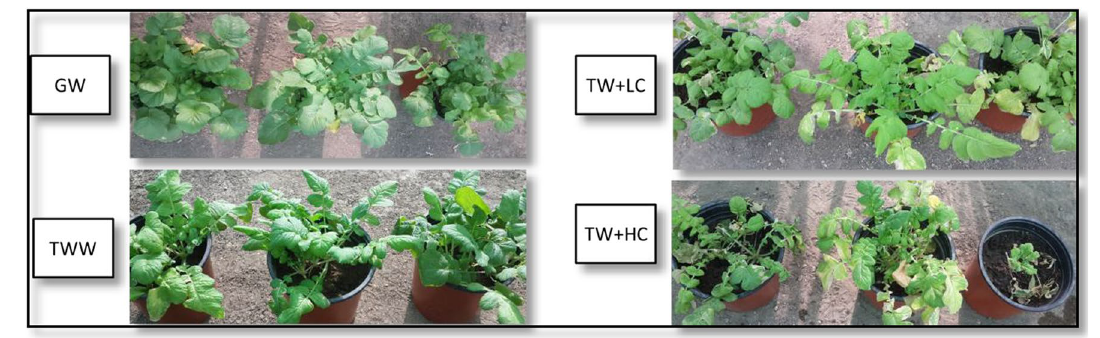
Fig. 2 Qualitative observation of plant health of the four different treatments, GW: groundwater, TWW: treated wastewater, TW + LC: treated wastewater with low concentration of mixed